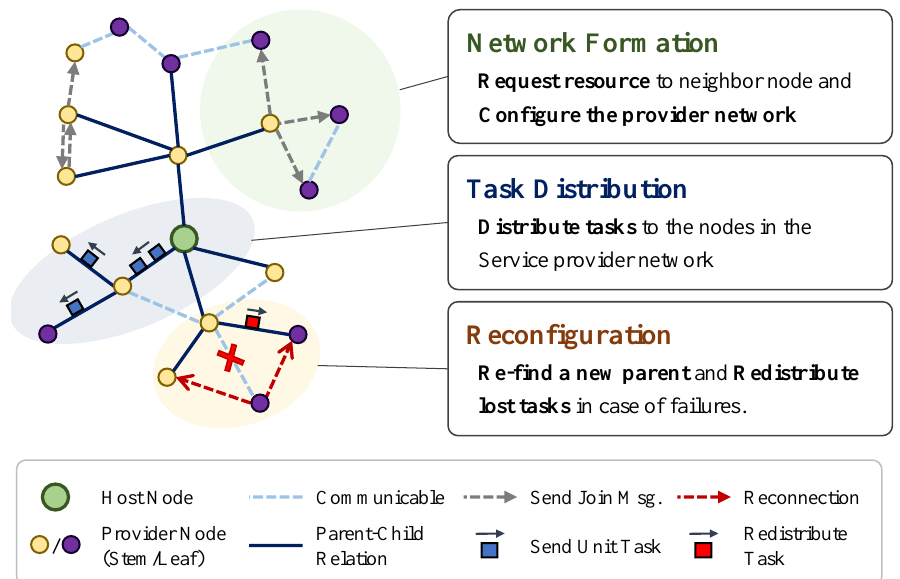
Figure 1. Computation offloading system framework consisting of network formation, task distribution, and